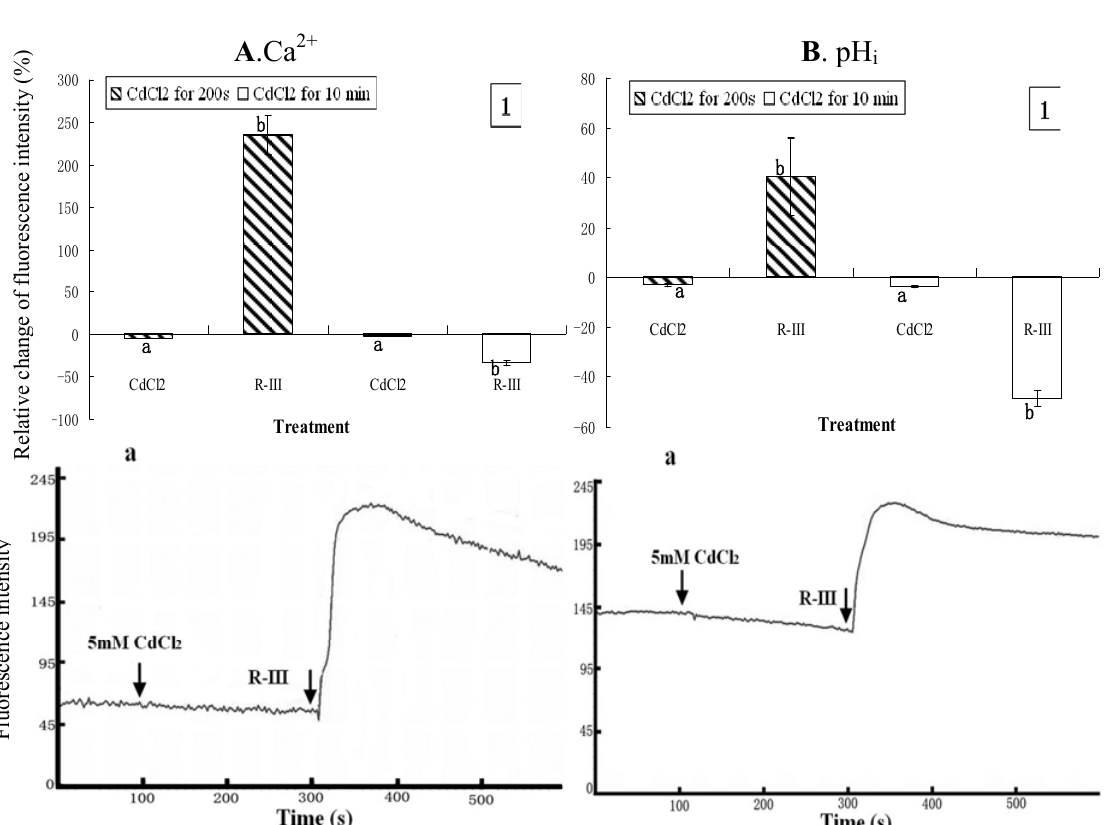
Figure 6. Effect of Ca 2+ channels block on [Ca 2+ ] and pH in R-III-induced Sf9 cells in i i presence of Hanks. ( A1 ). changes of [Ca 2+ ] in Sf9 cells treated with 0.5 mM CdCl for 200 s i 2 and10 min prior to stimulate with R-III (100 μ g/mL), as indicated by relative change of Fluo-3AM fluorescence intensity; ( A-a ). Dynamic changes of [Ca 2+ ] in Sf9 cells treated i with 0.5 mM CdCl for 200 s prior to stimulate with R-III (100 μ g/mL); ( A-b ). Dynamic 2 changes of [Ca 2+ ] in Sf9 cells incubated with CdCl (5 mM) for 10 min prior to stimulated i 2 with R-III (100 μ g/mL); ( B ). pH profile in cells subjected to the protocol in ( A ). Results of i representative experiment derived from three repetitions and 4–6 cells were measured in each repetition. The error bars represent mean ± SEM for data derived from value of relative fluorescence intensity in each time interval. Treatment means sharing the same letter were not significantly different from each other ( P < 0 . 05). The negative value meant decrease of relative fluorescence intensity in